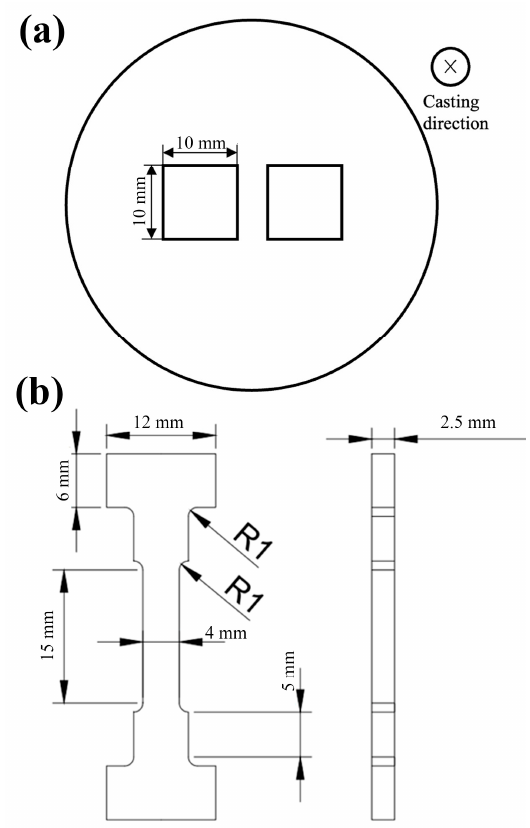
Figure 1. ( a ) Schematic diagram of sampling position and ( b ) dimension diagram of tensile speci ‐ men.